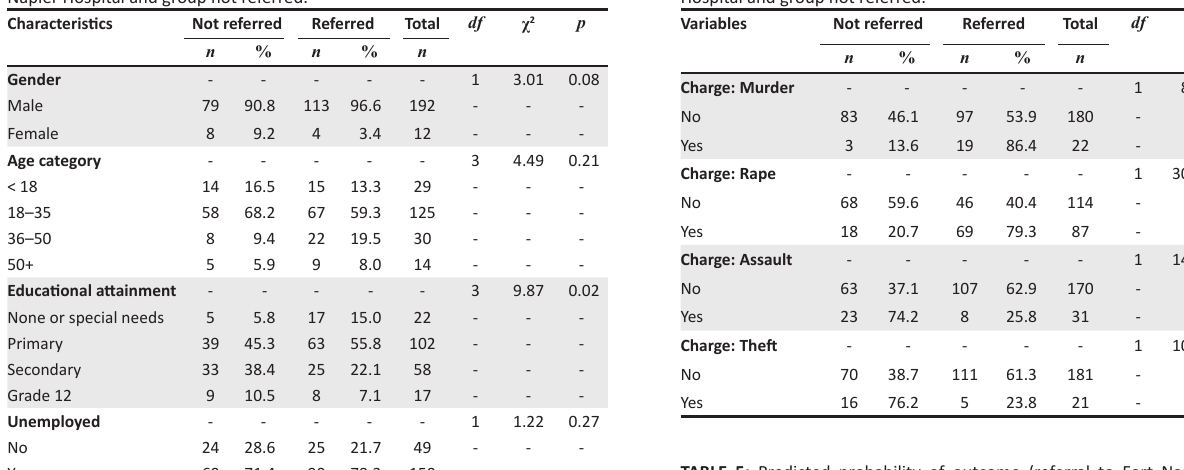
TABLE 5: Predicted probability of outcome (referral to Fort Napier Hospital recommendation) based on crime and clinical